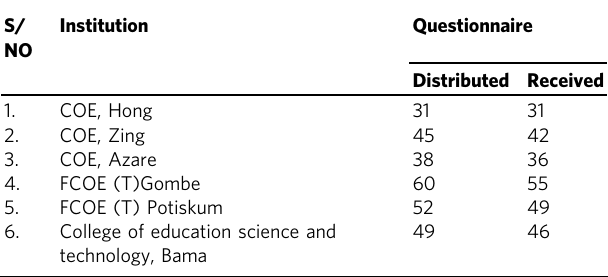
Table 1 Response rate from respondents.